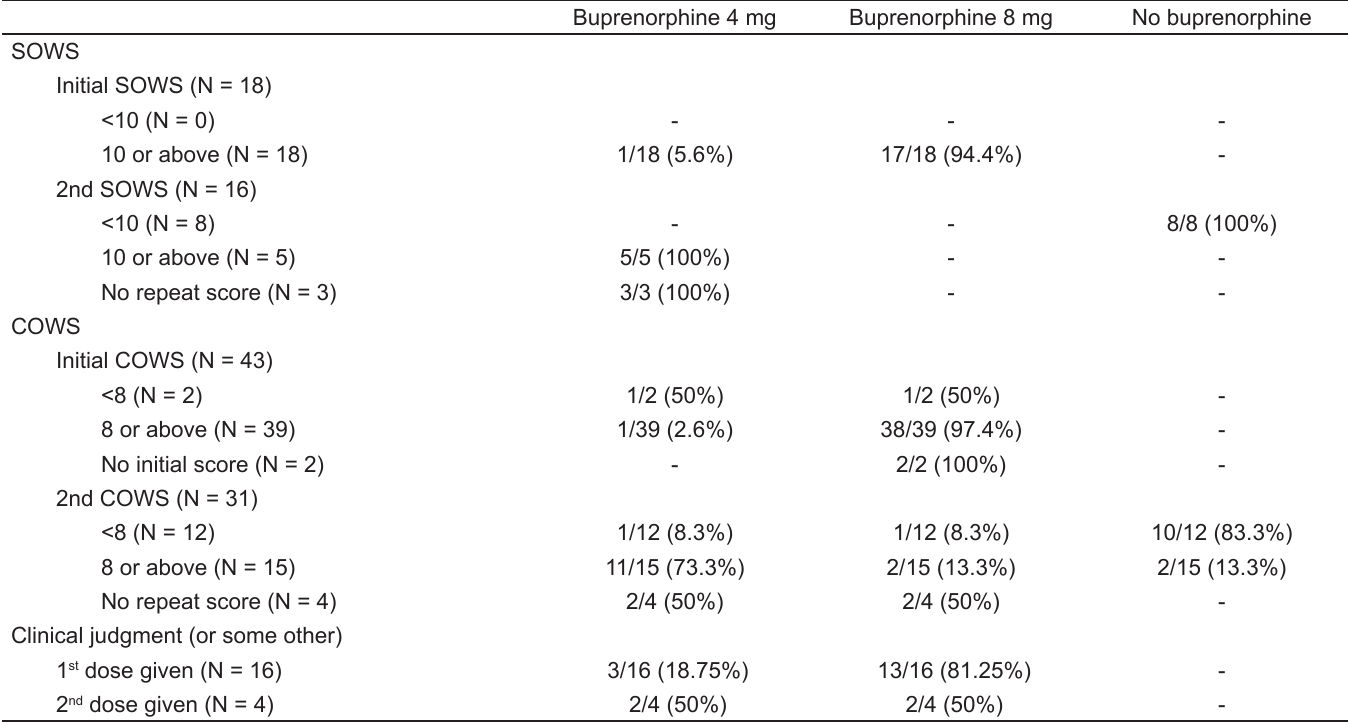
Table 2. Assessment scores and buprenorphine dose administered.